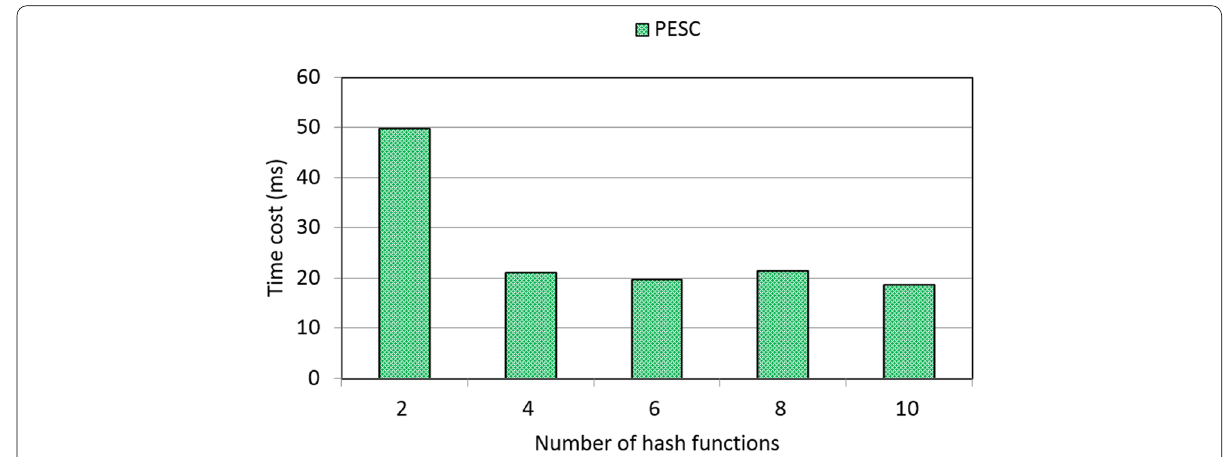
Fig. 6 Time cost of